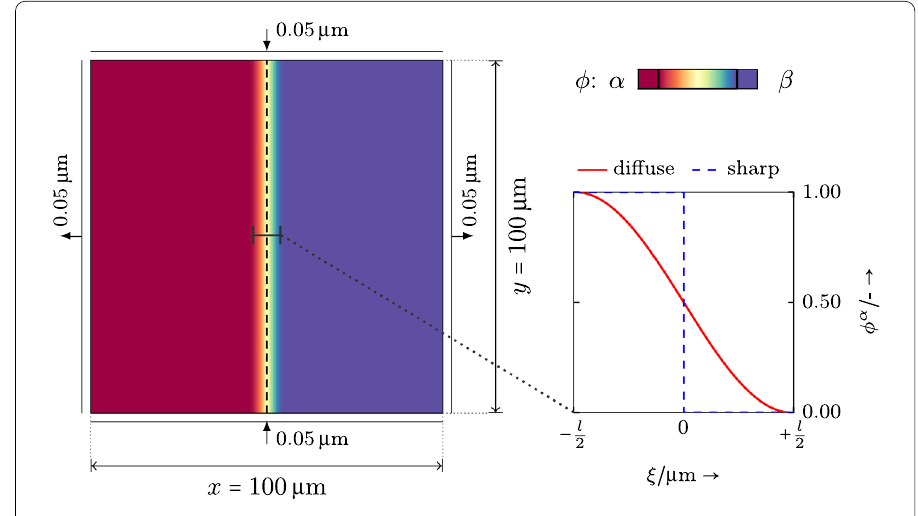
Fig. 5 Setup: Two phases, purely linear elastic α and linear visco-elastic β , are connected by a diffuse or sharp